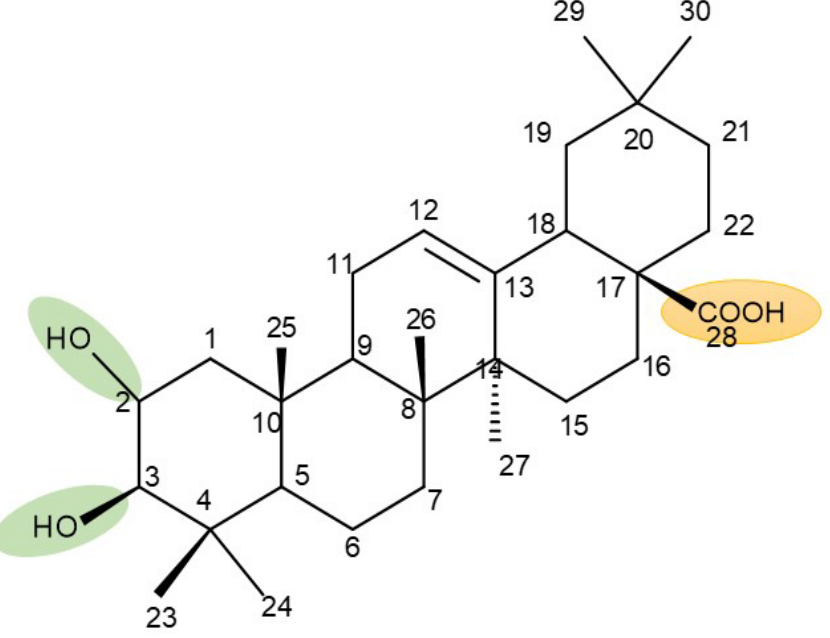
Figure 8. Frequent targets for the derivatization of maslinic acid.